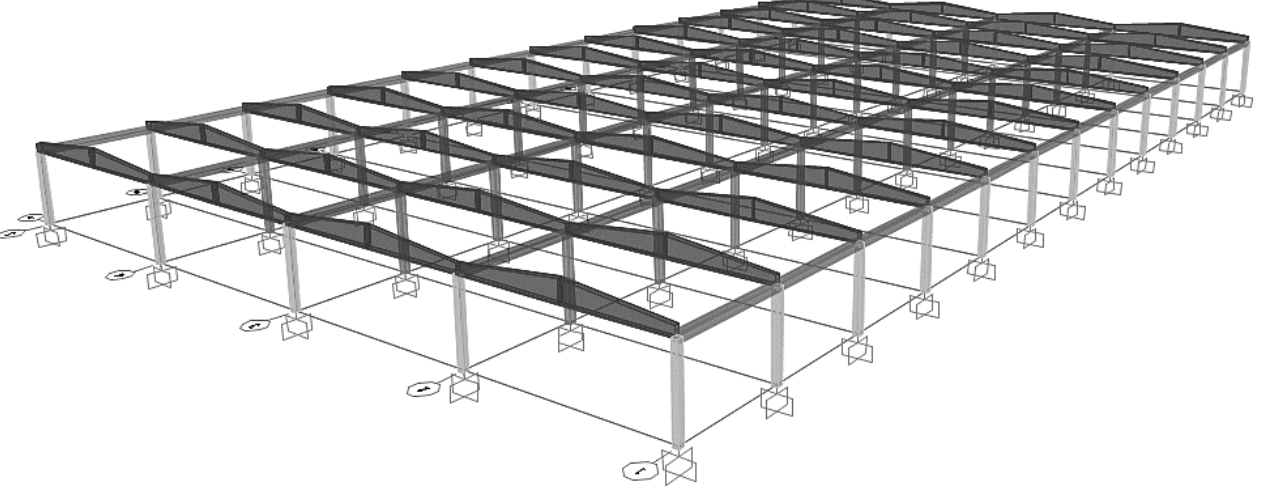
Figure 8. Three-dimensional FEM model.